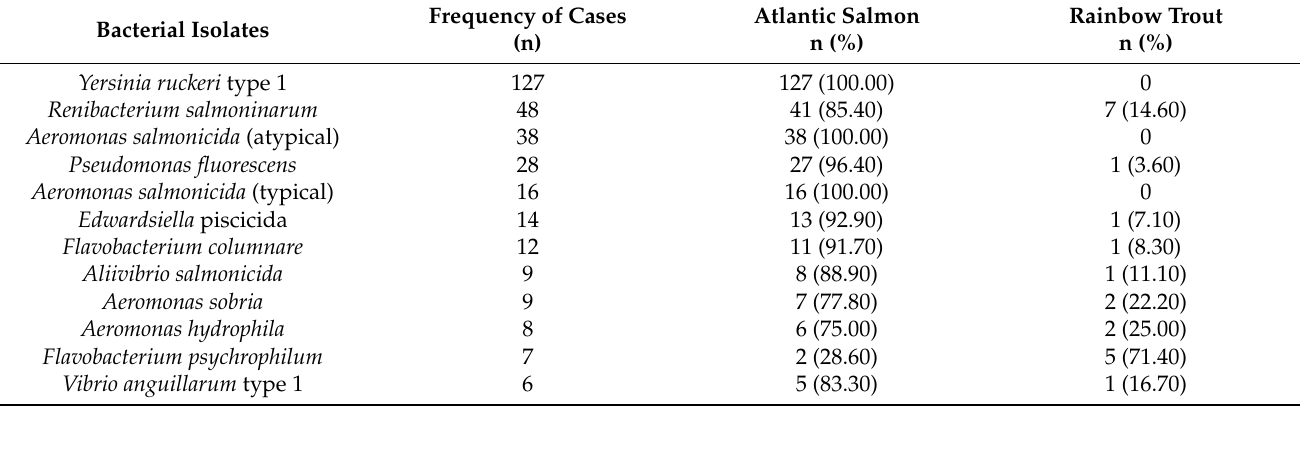
Table 1. Frequency of bacterial isolates detected in submitted cases to the AVC ADSBL by species of salmonid samples (2000–2021).